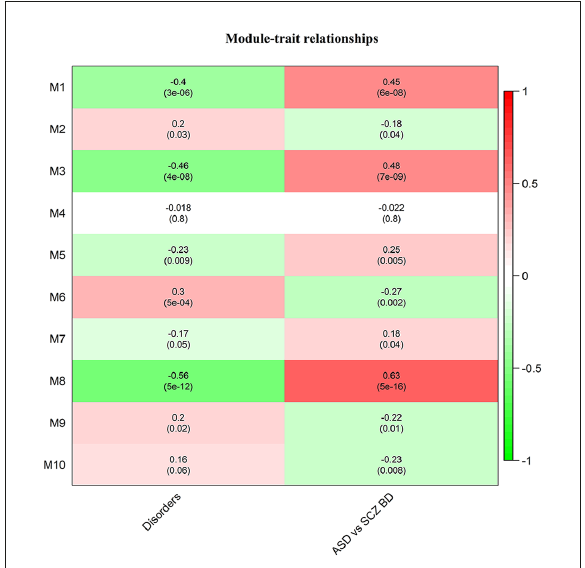
FIGURE3 Heatmap of correlation between the disease traits and module eigengene. Correlation with disorders is calculated based on ASD-1, SCZ-2, and BD-3, and ASD vs. SCZBD is calculated based on ASD-1 and SCZBD-0. The p -values are given in the bracket.